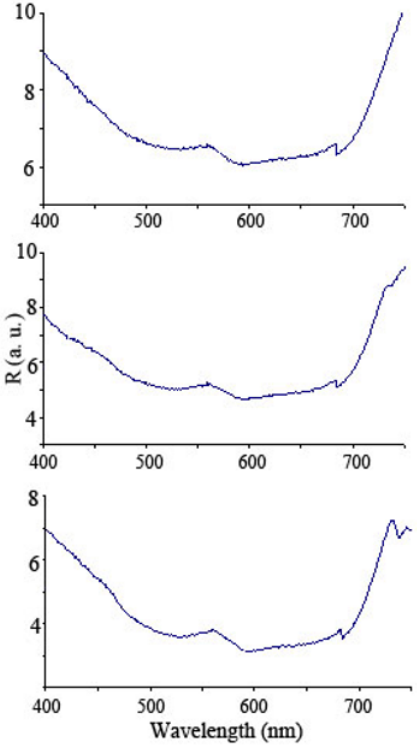
Figure 9. Optical micrographs of sol-gel-derived CoAl composition of CoAl